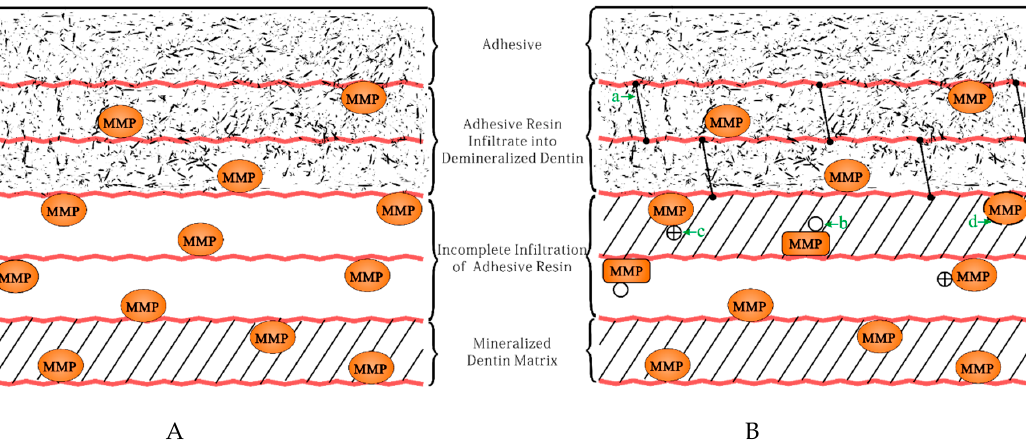
Figure 2. Schematic drawing presents the mechanism of MMPs-inhibiting adhesives. A: The common condition of resin-dentin bonding; B: The different way of inhibiting MMPs. (a) Cross-linking of collagen. (b) Changing conformation of MMPs. (c) Electrostatically binding to catalytic site of MMPs. (d) Entrapping MMPs and collagen in the newly-formed crystal.